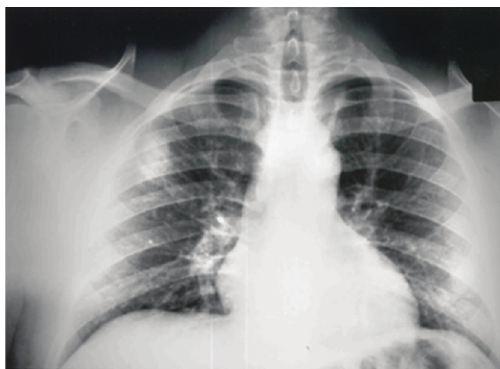
Figure 1: Chest X-ray revealing a rounded opacity in the right upper lobe.